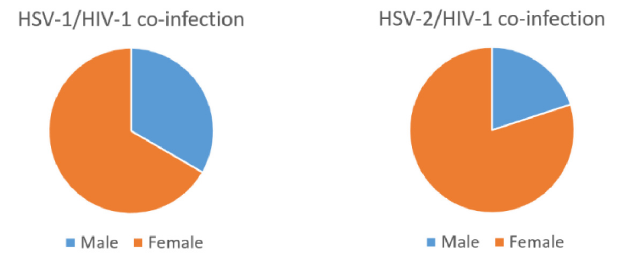
Figure 1. Gender categorization of PCR data of the HSV-2/HIV- 1 and HSV-1/HIV-1 co-infected